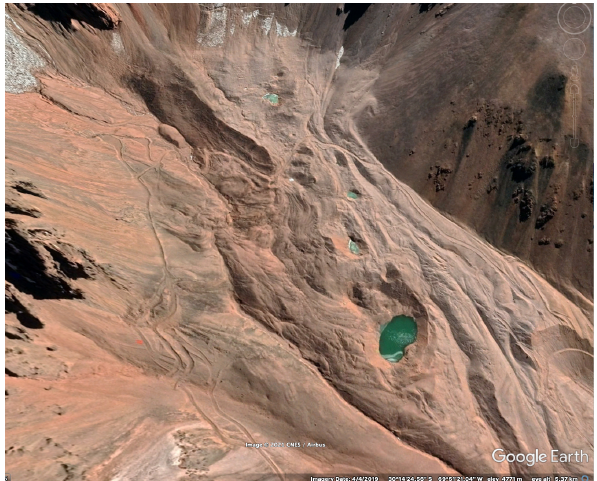
Figure 1. A glacigenic rock glacier centred on the prominent sur- face melt pool at [-30.2414,-69.8541] shows ablation of massive, glacier-derived, ice under a debris cover. These melt pools can be traced from the uppermost part of the rock glacier through to near the snout and are persistent over several years of Google Earth im- agery. A permafrost (talus-derived) feature would show “isovolu- metric” melting of ice in pore spaces and thus have a rather differ- ent water storage capability from a glacier core. © Google Earth/C-